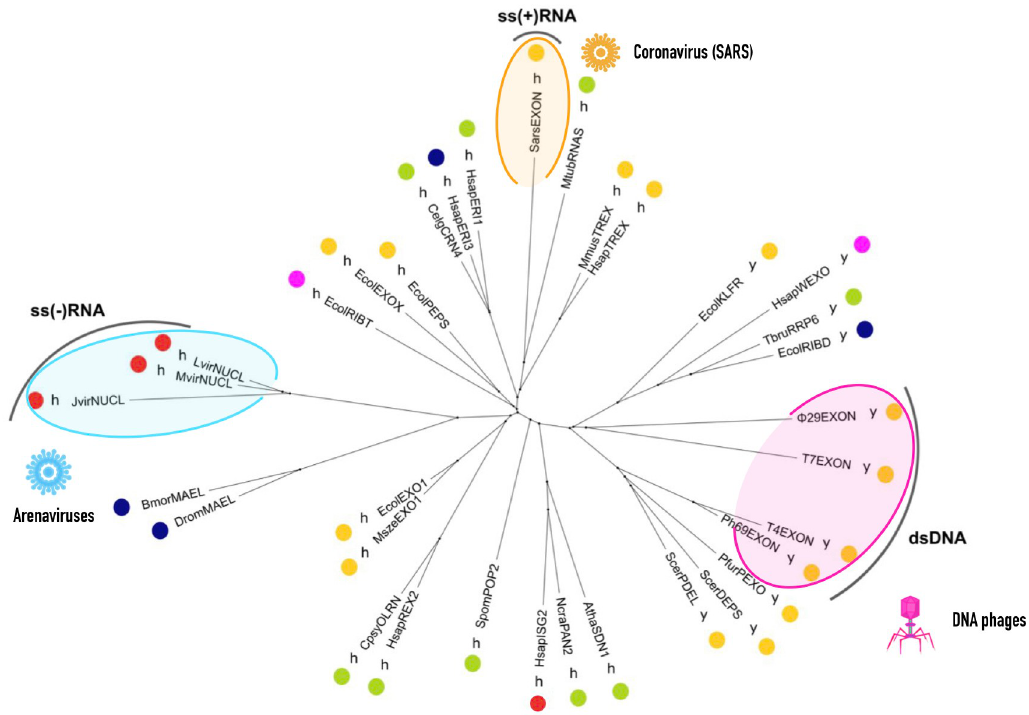
Fig 1. Unrooted tree based on the structural comparisons of DEDD exonucleases. The dots indicate exonuclease function, which colors stand for: yellow, proofreading; green, cytoplasmic RNA and/or DNA degradation; red, immune activity; dark blue, RNA processing and maturation; fuschia, DNA repair. The single letters indicate the DEDD exonuclease subgroup according to the fifth most conserved residue in the catalytic core: y, DEDDy subgroup; h, DEDDh subgroup. The tertiary structures of the exonucleases and their respective abbreviations used in this analysis were: DNA polymerase I klenow fragment, EcolKLFR; Exonuclease I, EcolEXO1; RB69 gp43 DNA polymerase, Ph69EXON; Phage T7 exonuclease, T7EXON; Phage T4 exonuclease, T4EXON; Phage phi29 exonuclease, ϕ 29EXON; Nuclease domain of 3’hExo, HsapERI1; Human ISG20, HsapISG2; TREX2 3’ exonuclease, HsapTREX; RNase D, EcolRIBD; WRN exonuclease, HsapWEXO; Pol III epsilon-hot proofreading